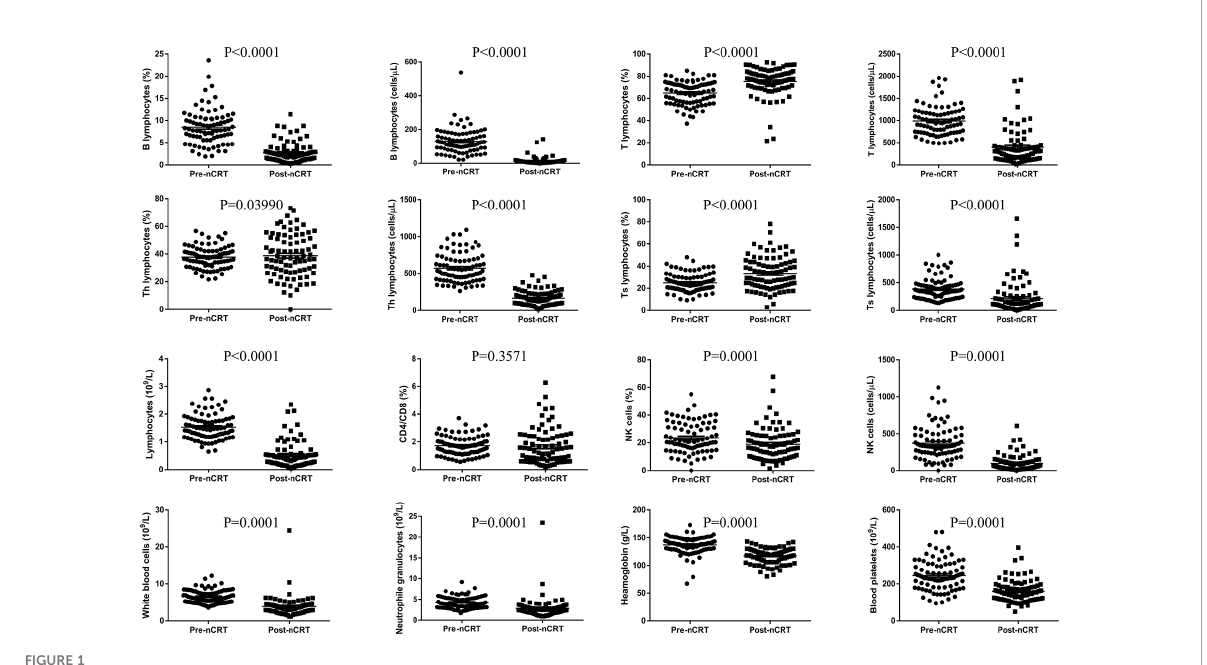
FIGURE 1 Changes in lymphocyte subsets, peripheral blood cells, and haemoglobin.